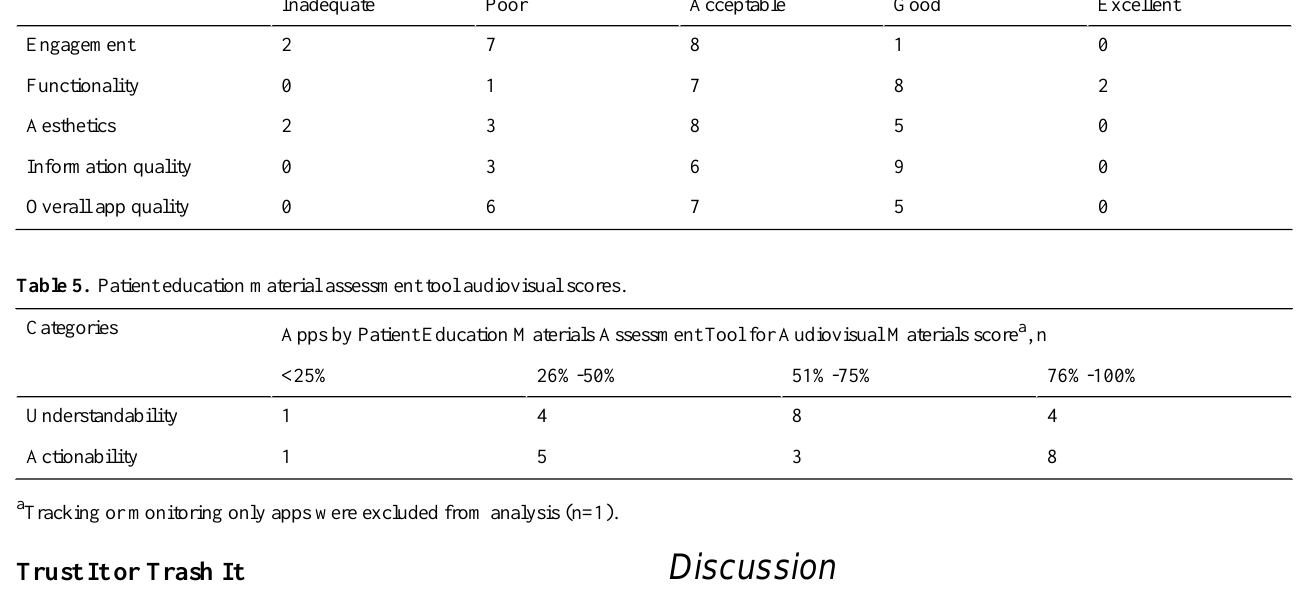
Apps by average score, nCore subscales